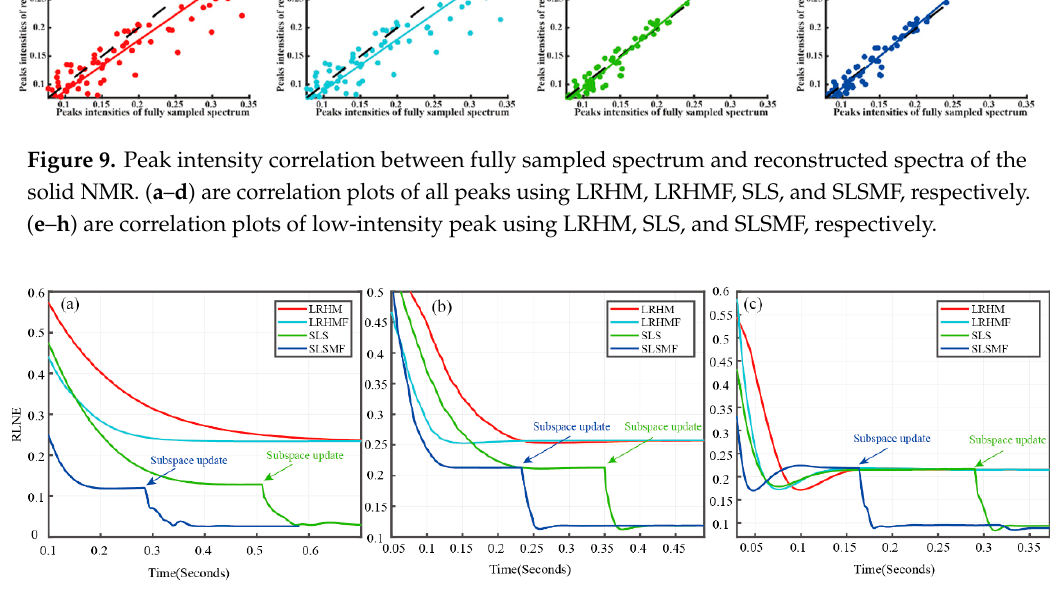
Figure 10. The RLNEs versus times of different approaches. ( a – c ) are the RLNE curves of the 1D experiments marked with a dotted line in Figures 3 a , 4 a, and 5 a , respectively. Note: The point indicated by the arrow in the Figure is to update the outer subspace.